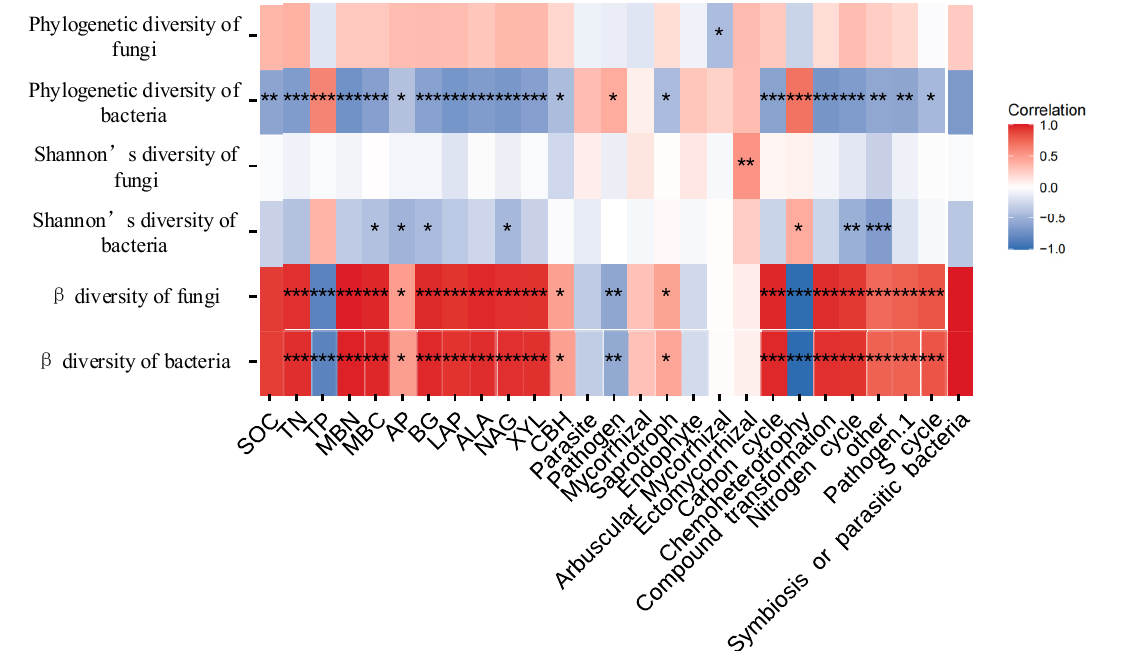
Figure 5. The relationships between single soil functions and Shannon indexes, phylogenetic diversities, and communities compositions of bacteria and fungi. *: p < 0.05, **: p < 0.01, *** p < 0.001.